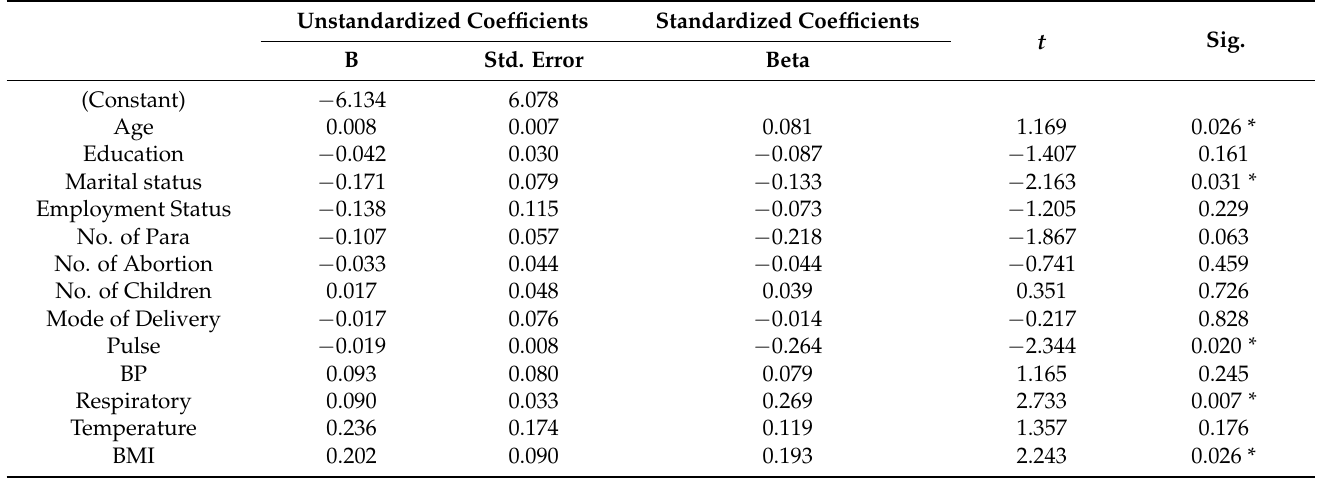
Table 5. Regression test for factors affecting urinary incontinence